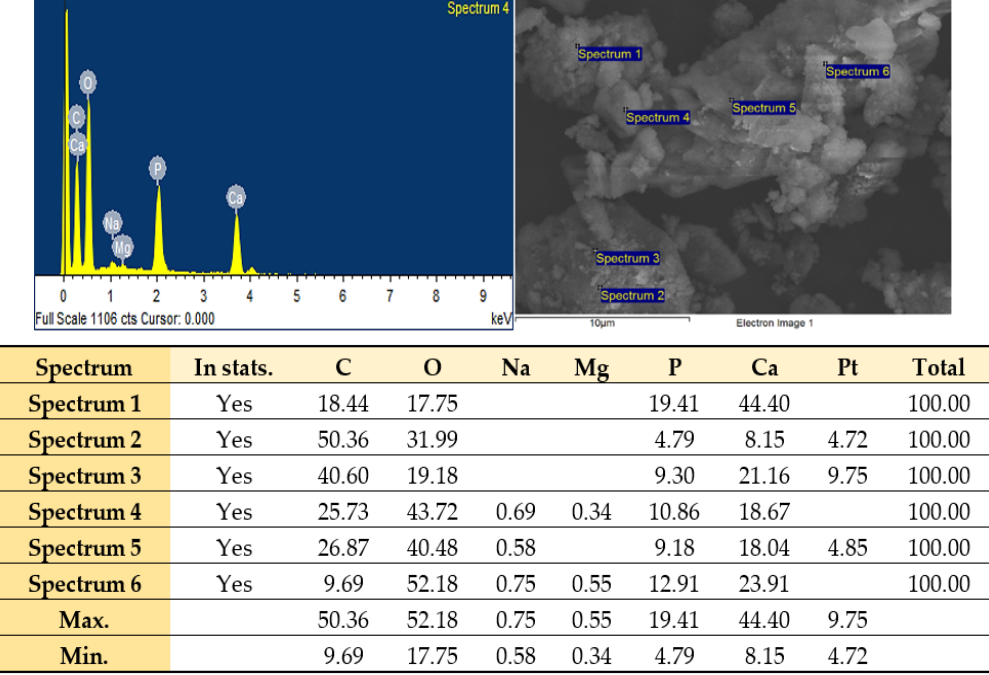
Figure 2. Representative EDX spectra for elemental analysis of GBA suspension.